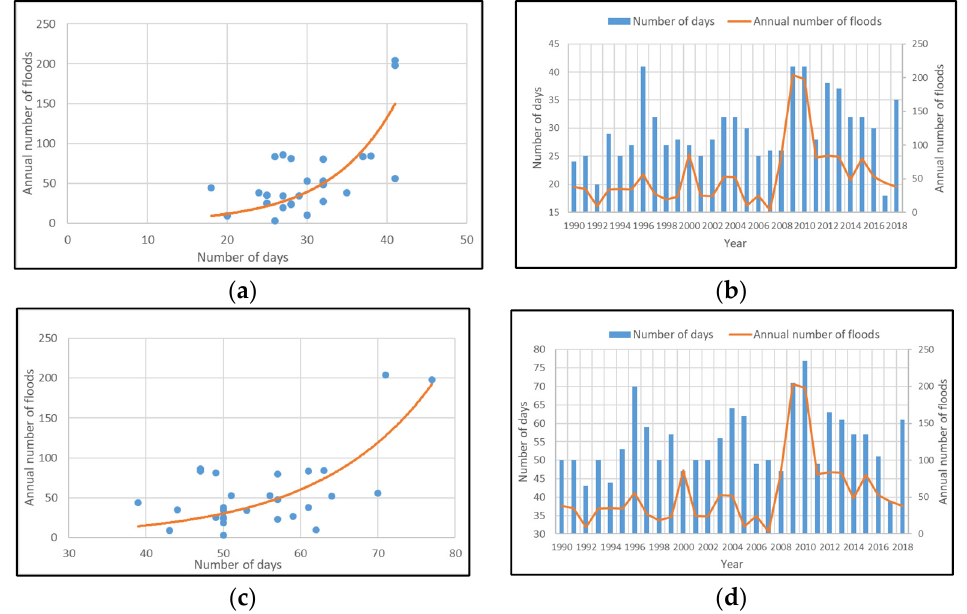
Figure 3. Two examples of the best comparisons between number of floods and climate indices for